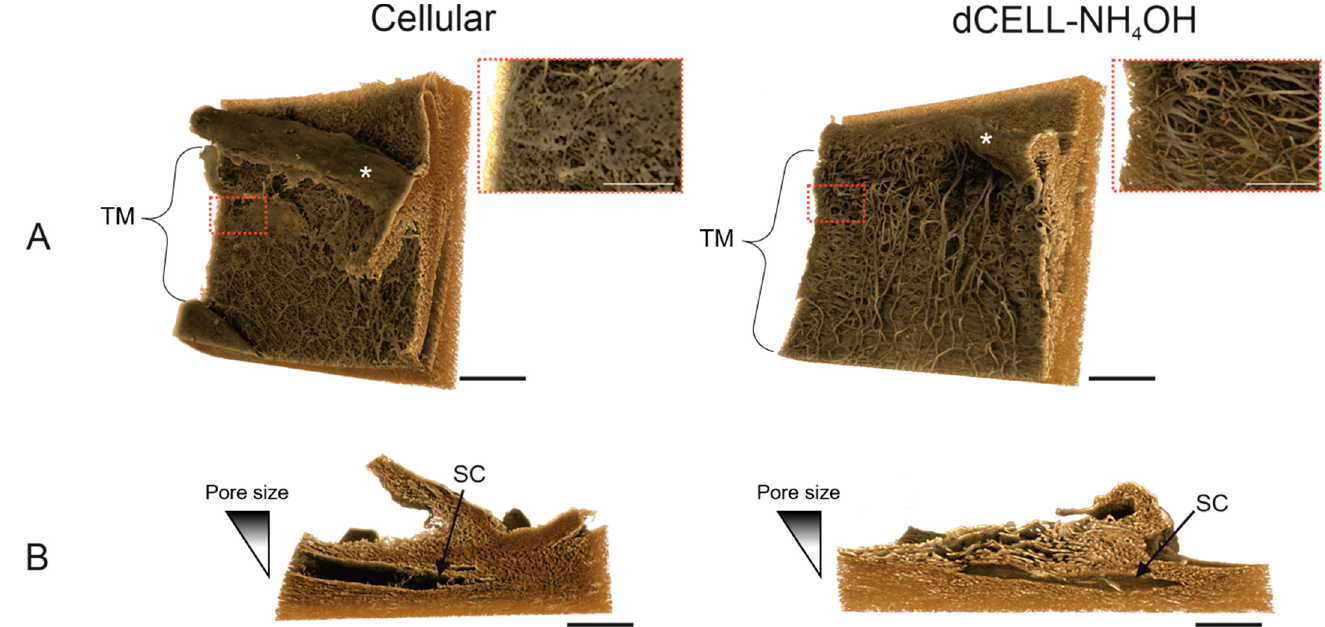
Figure 6. X-ray computed tomography images of cellular and dCELL–NH 4 OH human trabecular meshwork shown in ( A ) front-on and ( B ) cross-sectional orientations. Red dashed boxes indicate region of interest for zoomed-in views. Trabecular meshwork (TM) and Schlemm’s canal (SC) indicated by curly bracket and black arrow, respectively. * represents where the iris was removed to allow visualization of the TM. (( A ): Scale bar = 200 µm; inset scale bar = 50 µm and ( B ): Scale bar = 200 µm).